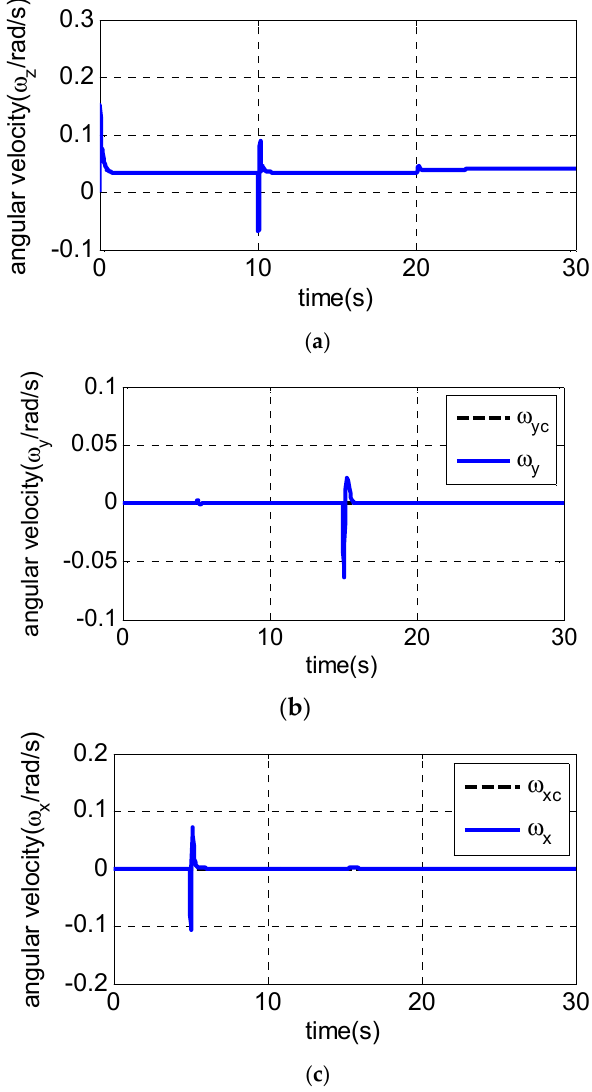
Figure 4. Simulation results of angular velocity of three channels: ( a ) angular velocity ω z of pitch channel; ( b ) angluar velocity ω y of yaw channel; and ( c ) angluar velocity ω x of roll channel.